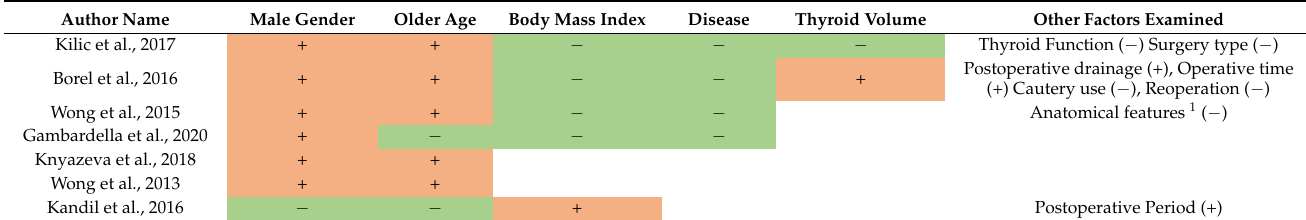
Table 3. Risk Factors for